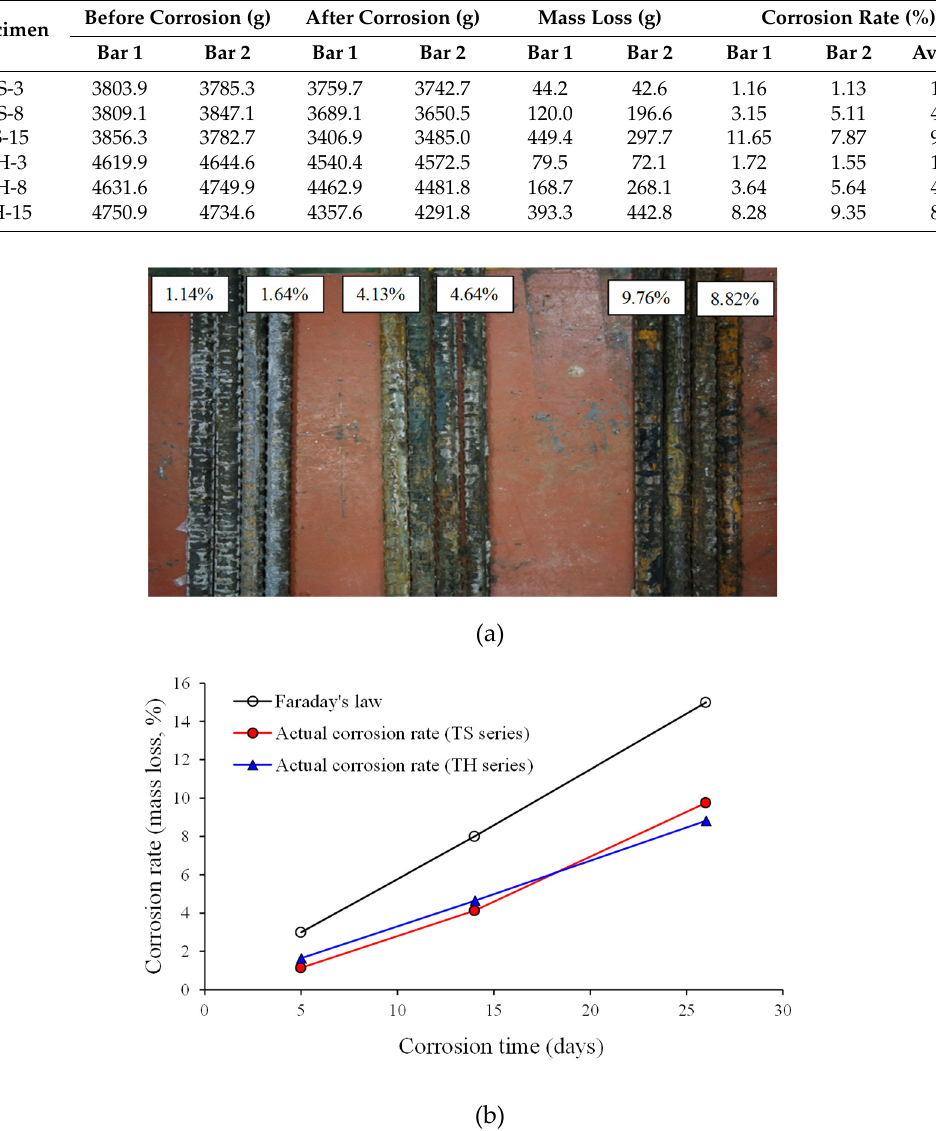
Figure 4. Accelerated corrosion test results. ( a ) Corroded longitudinal reinforcement extracted from test specimens; ( b ) Target and measured corrosion rates of test specimens.